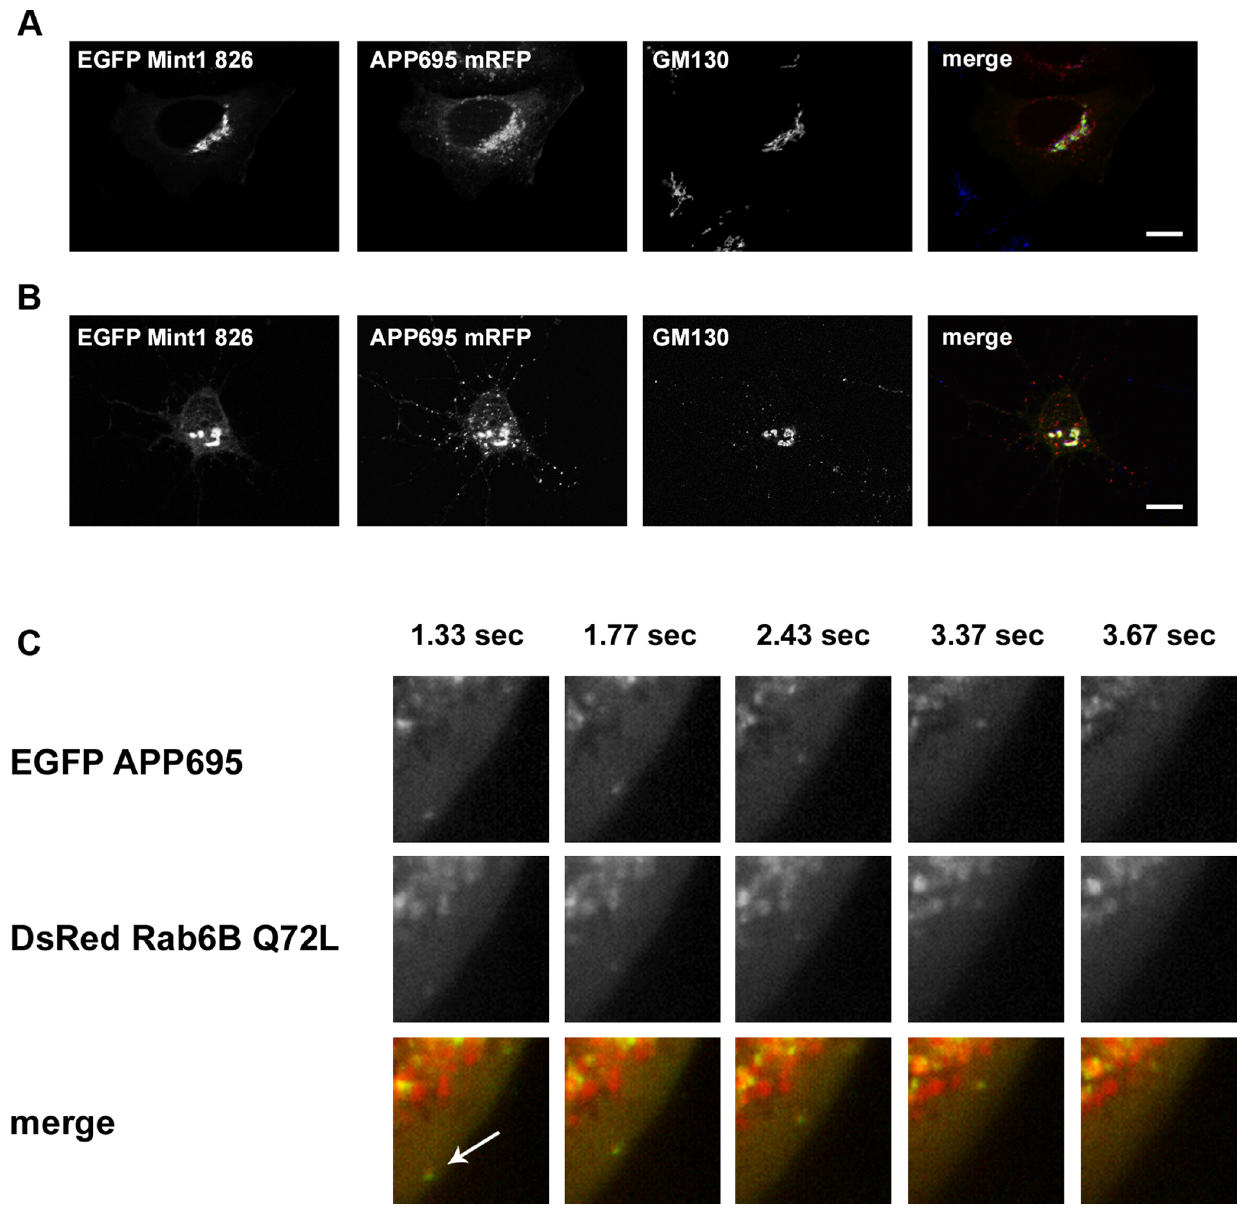
Figure 9. Fluorescence analyses of Rab6, Mint1 826 and APP. A) Co-staining of Mint1 826, APP and GM130 in HeLa cells. Cells were co- transfected with pEGFP Mint1 826 and pCDNA3.1 APP 695 RFP and subsequently incubated with anti-GM130 and anti-mouse Alexa488 antibodies. Scale bar: 20 m m. B) Co-staining of Mint1 826, APP and GM130 in primary mouse neurons. Cells were co-transfected with pEGFP Mint1 826 and pCDNA3.1 APP 695 RFP and subsequently incubated with anti-GM130 and anti-mouse Alexa488 antibodies. Scale bar: 20 m m. C) Live cell imaging of Rab6B and APP. CV1 cells were co-transfected with pDsRed monomer Rab6B Q72L and pEGFP APP 695 and imaged 18 h after transfection.